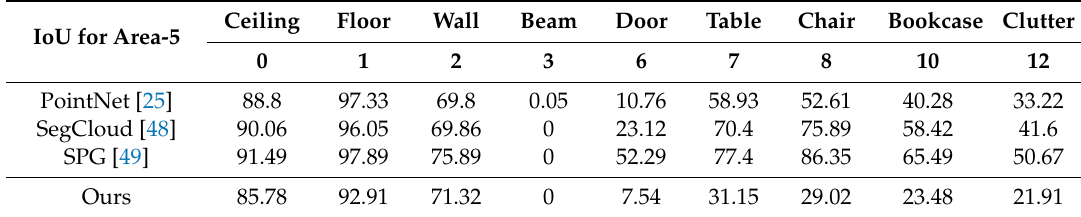
Table A1. Intersection-over-Union on Area 5 of our methodology compared to PointNet [25],